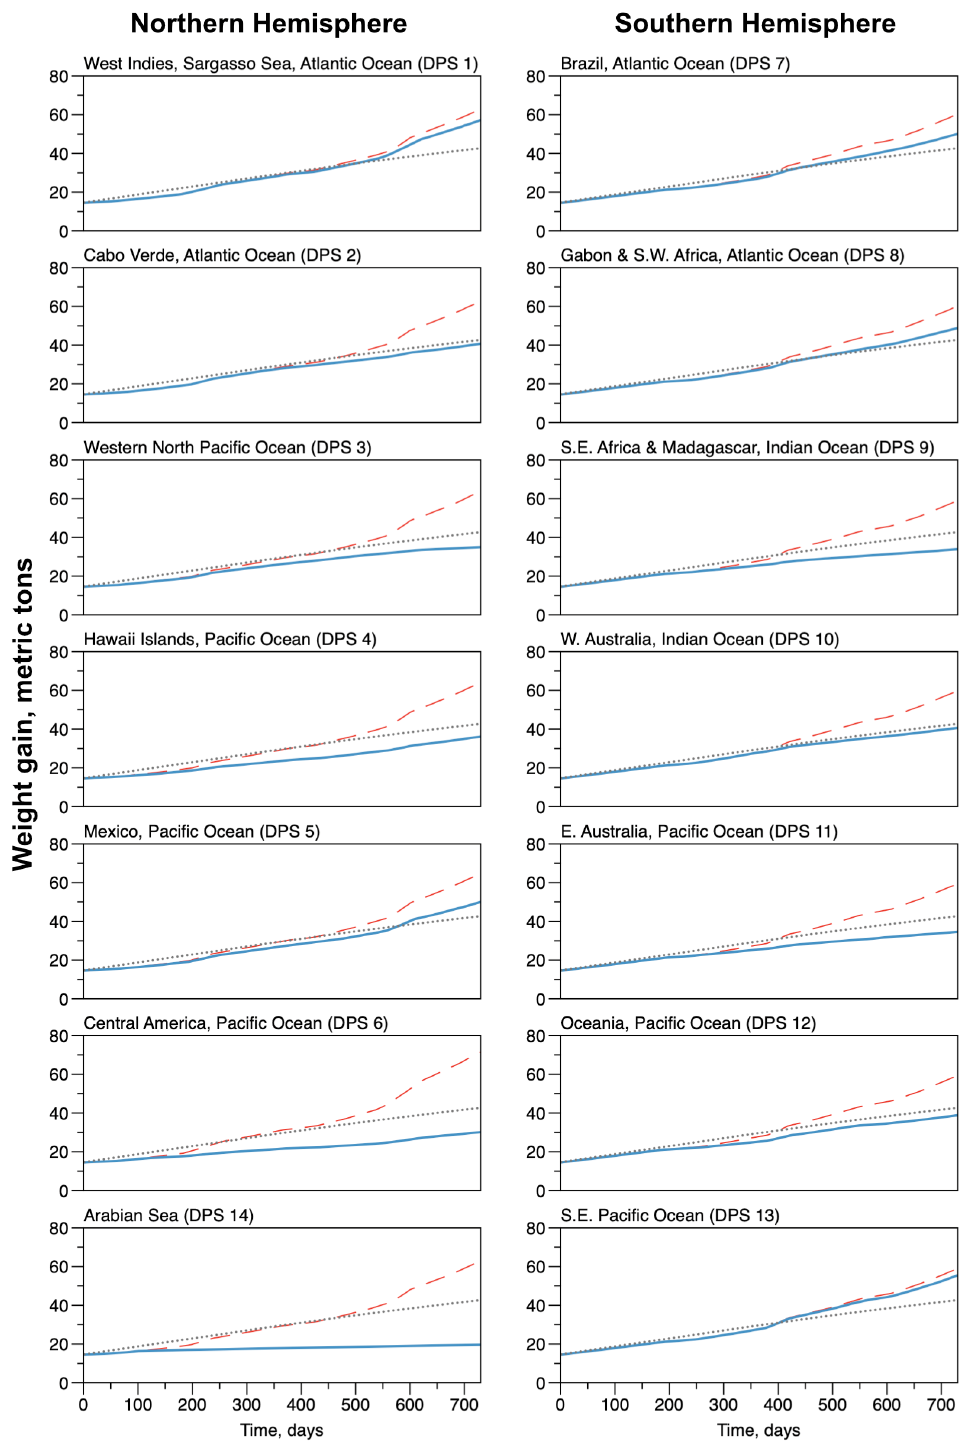
Figure 8. Average weight variations for the groups of whales corresponding to each of the Distinct Population Segments. The dashed gray line shows the total weight (upper line) calculated as a nominal isometric growth. Red dashed lines show the total weight evolution in a configuration where the depth of the ocean was constant ( − 1000.0 m) without any emerged land. The blue lines show the total weight in the simulations with the actual Earth topography, estimated at 1 arc-minute